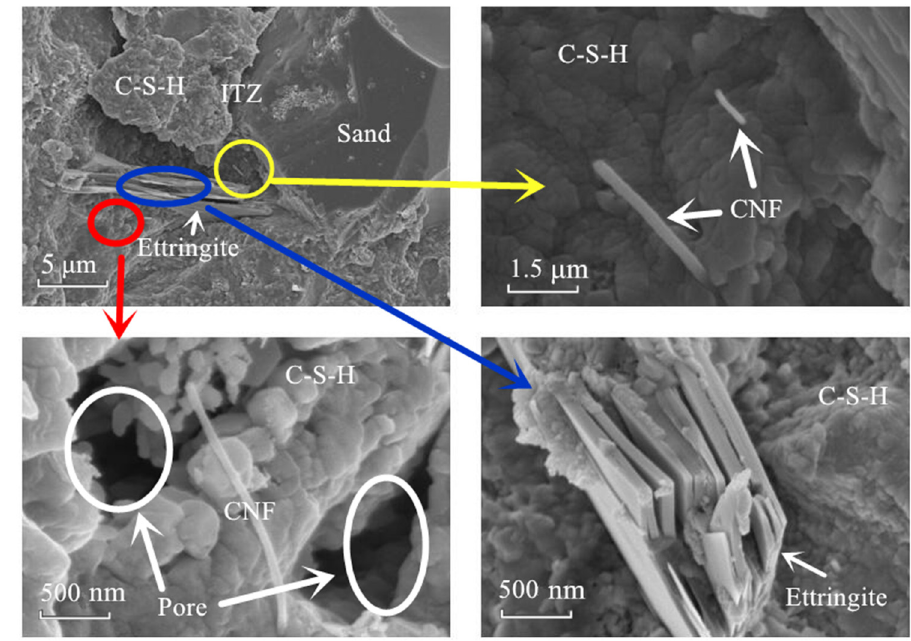
Figure 15: Microstructure of the UHPC with CNF at 28